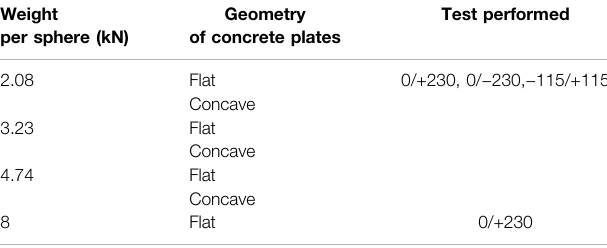
TABLE 2 | Summary of the tested con fi